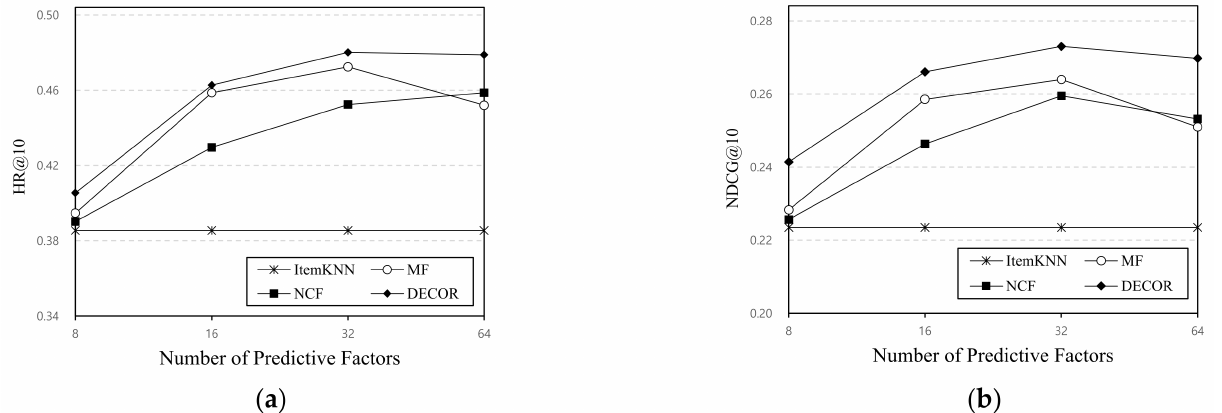
Figure 3. This figure shows the changes in model performance induced by changing the number of predictive factors: ( a ) HR@10 performance based on the number of predictive factors; ( b ) NDCG @10 performance based on the number of predictive